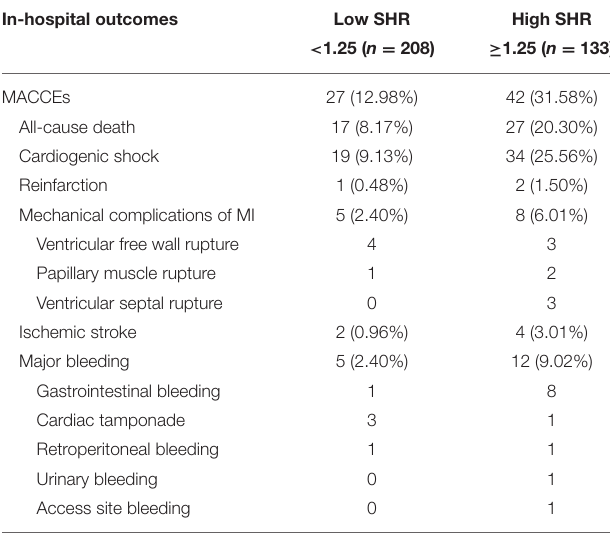
TABLE 2 | In-hospital outcomes in low and high SHR groups.